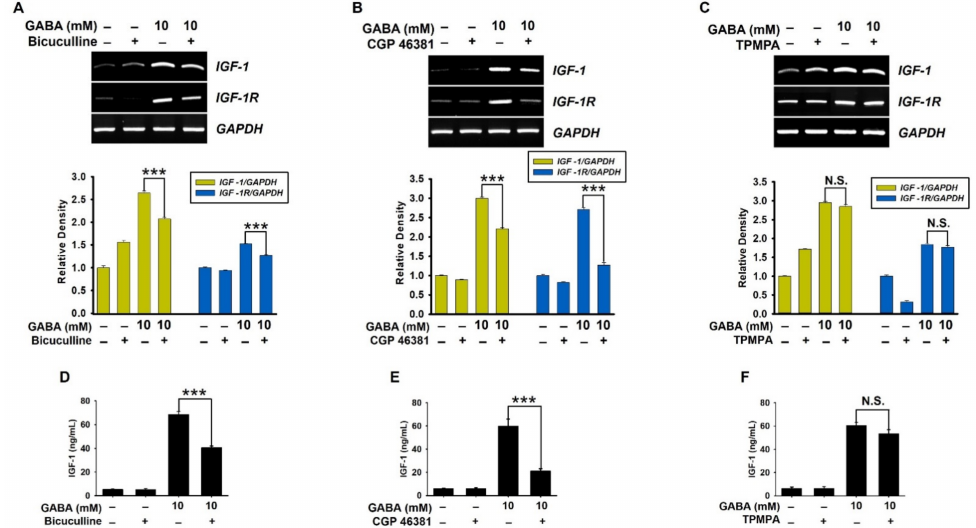
Figure 4. GABA upregulates growth-stimulating gene expression via GABA A and GABA B receptors. Zebrafish larvae ( n = 20) at three days post-fertilization (dpf) were treated with 10 µ M of each ( A ) bicuculline, ( B ) CGP 46381, and ( C ) TPMPA 2 h before treatment with 25 mM GABA, and total RNA was extracted at 9 dpf. The RNA was reverse-transcribed, and synthetic cDNA was amplified to determine expression of the genes for insulin-like growth factor 1 ( zIGF-1) , growth hormone 1 ( zGH-1 ), growth hormone receptor 1 ( zGHR-1 ), and cholecystokinin A ( zCCKA ). z β -Actin was used as an internal control. Densitometry analysis was conducted to determine the expression level of each gene relative to that of β -actin and illustrated ( bottom ). Significant differences among the groups were determined using Student’s t -test. All data are presented as mean ± standard error of the mean (*** p < 0.001). N.S., non-significant.